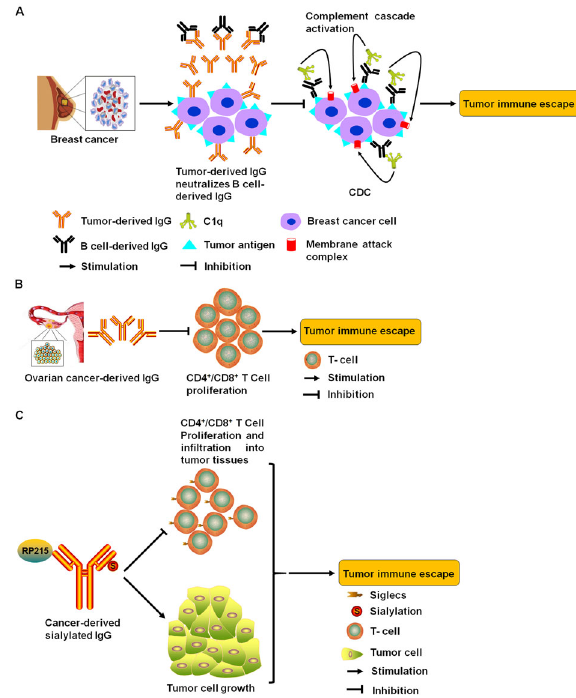
Fig. 6 Schematic illustration of the mechanisms that tumor- derived Igs strengthened tumor immune escape. A Tumor-derived IgG neutralized B-cell-derived IgG to block CDC in which the formation of a complex, including B-cell-derived IgG, tumor antigen, and C1q, activated complement cascade to lysis tumor cells with the help of membrane attack complex in breast cancer cells. Finally, breast cancer cells escaped from the host immune system. B Tumor- derived IgG inhibited the proliferation of CD4 + or CD8 + T cells from CBMC and CBL to facilitate ovarian cancer immune escape. C The sialylation modi fi cation mediated the binding between tumor- derived IgG, which was recognized by RP215, and Siglecs on effector CD4 + and CD8 + T cells, which fi nally resulted in tumor immune escape due to the immunosuppressive effect of the above T cells and the promotion of tumor cell growth.